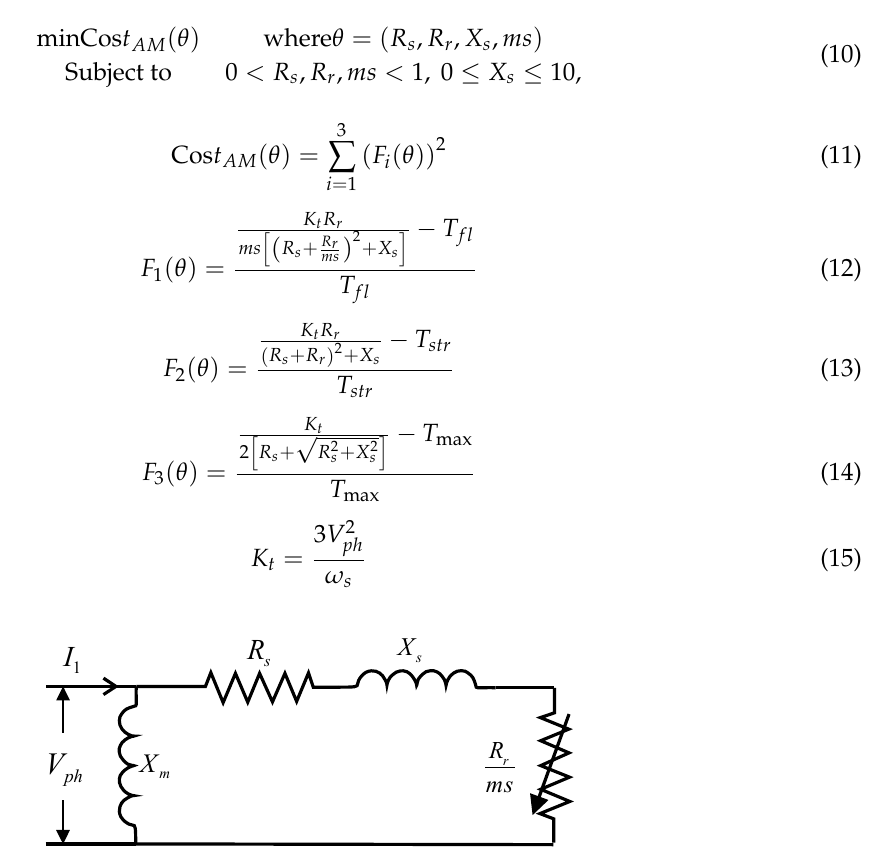
Figure 2. Approximate circuit model.